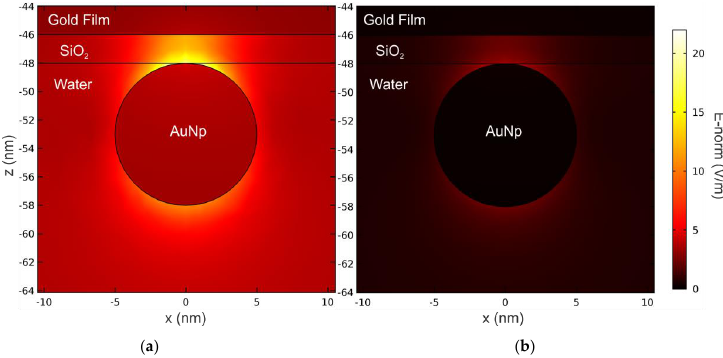
Figure 12. Norm of the near electric field surrounding an AuNP for a thin dielectric spacer layer with a thickness of 2 nm, calculated at the wavelengths of ( a ) 633 nm and ( b ) 783 nm. Fixed parameters: h Au = 46 nm, 2 a = 10 nm, σ = 40 NP/µm 2 , and θ = 60°.